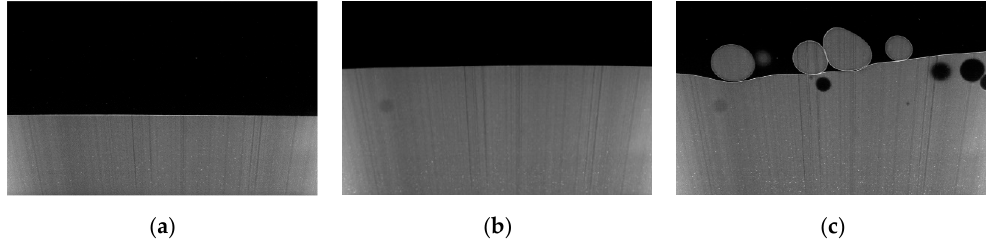
Figure 9. PLIF images for the flow conditions in the +3° inclined pipe: ( a ) Usa = 0.052 m/s, Uso = 0.15 m/s, ST flow; ( b ) Usa = 0.222 m/s, Uso = 0.15 m/s, ST flow; ( c ) Usa = 0.393 m/s, Uso = 0.15 m/s, ST&MI flow.